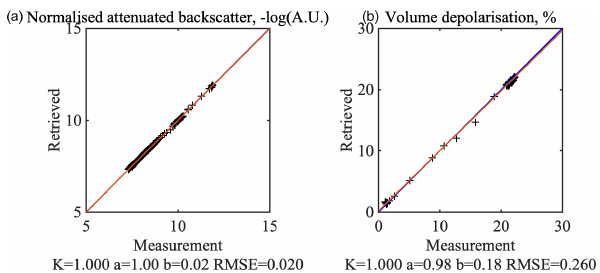
Figure 35. Achieved fits for attenuated elastic backscatter at 355nm (a) and 1064nm (b) and volume depolarization at 532nm; data acquired on 16 April